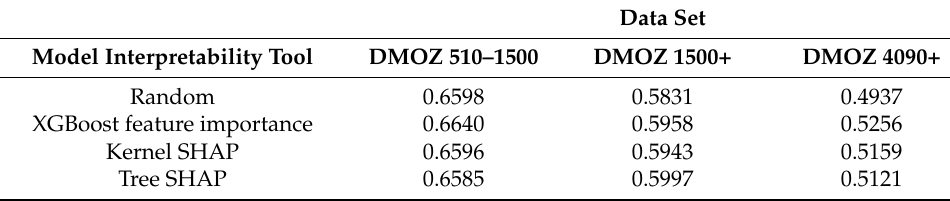
Table 3. Influence of the XAI method for acquiring the feature importance used to sort the list of important token features (sITFL). Experiments were performed with Text Guide by using all occurrences of important token features found in the original text